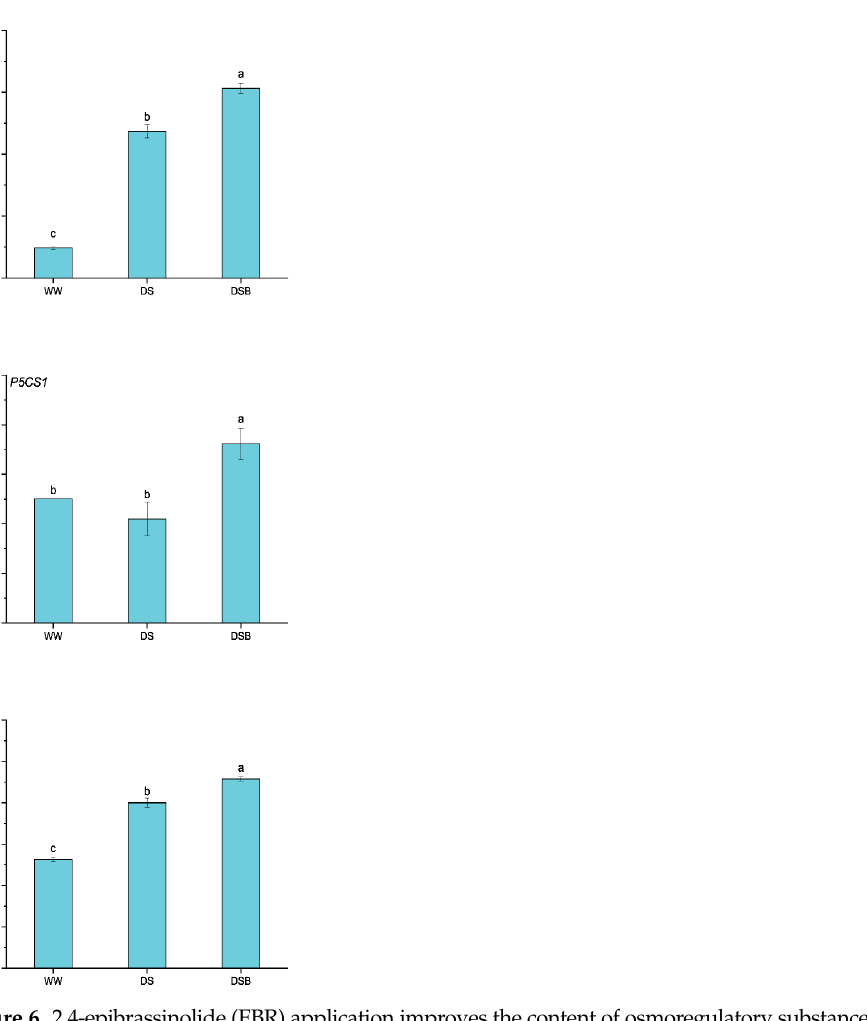
Figure 6. 2,4-epibrassinolide (EBR) application improves the content of osmoregulatory substances under drought stress. This figure comprises proline content ( A ), P5CS1 -proline biosynthesis gene expression ( B ), and soluble sugars content ( C ). The data are presented as means ± SE in the three treatments including WW (well ‐ watered), DS (drought stress), and DSB (drought stress + 0.05 mM EBR application). Error bars represent SE of the mean; different letters on bars show significant differences at p < 0.05 using the LSD test.